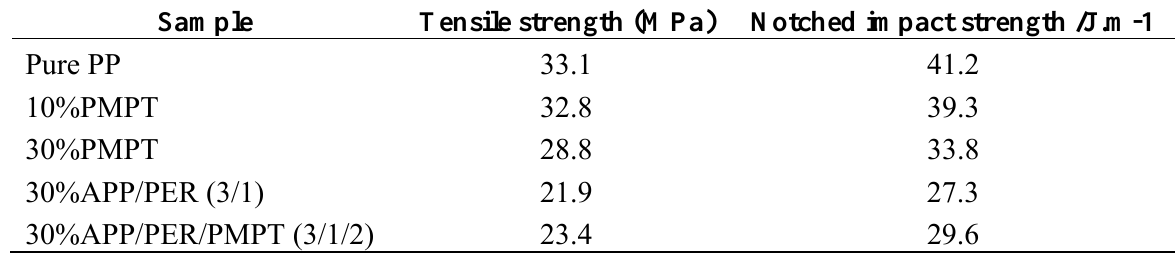
Table 2. The mechanical properties of FR-PP with the different flame